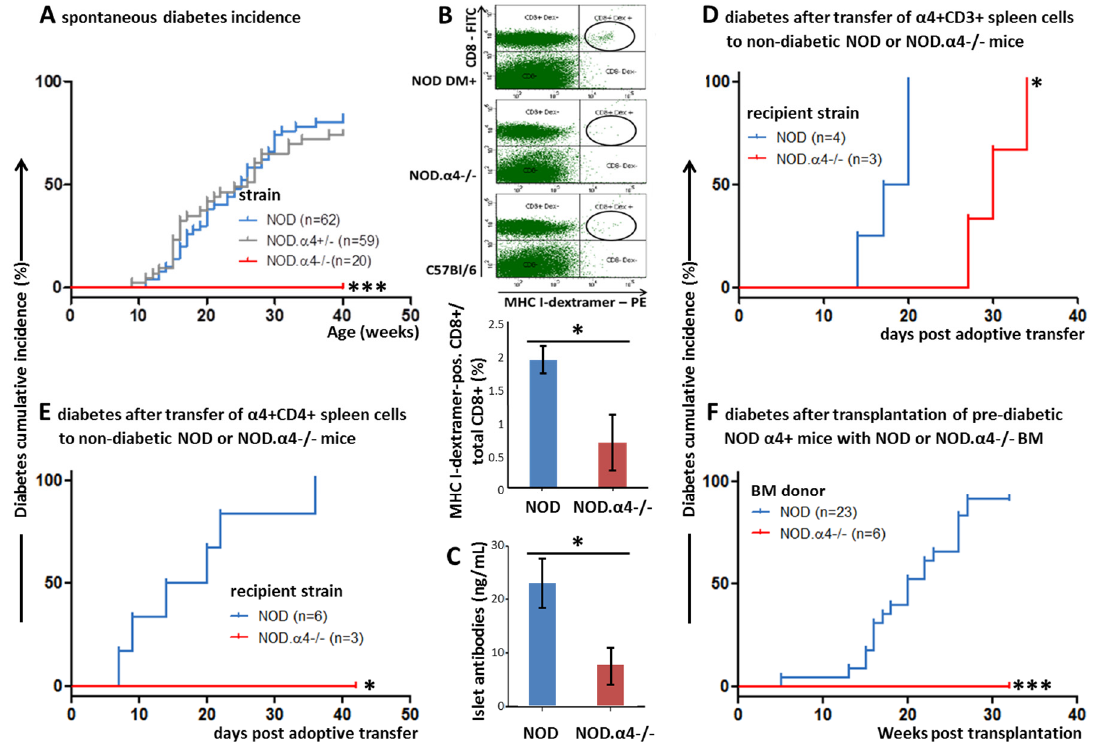
Figure 1. Diabetes and adaptive immune responses against islet antigens. Diabetes was diagnosed on the basis of recurrent hyperglycemia. Spontaneous diabetes development was tracked in α 4-WT (NOD, blue), α 4-haploinsufficient NOD (NOD. α 4+/-, grey) and α 4-deficient NOD (NOD. α 4-/-, red) mice. The cumulative diabetes incidence after 40 weeks in the two α 4-competent strains was 82% (NOD) and 75% (NOD. α 4+/-), respectively ( p = n.s.), while none of the NOD. α 4-/- mice developed diabetes ( p < 0.001 vs. both α 4-competent strains) ( A ). MHC-I dextramer H-2Kd/VYLKTNVFL binding to CD8+ T-cells was assessed by flow cytometry. Shown are representative dot plots for NOD, NOD. α 4-/- and MHC-disparate C57Bl/6 (negative control) mouse blood (upper panel) as well as quantitative analysis (lower panel) where dextramer-positive events in negative control blood were subtracted as background ( n = 9 per group; p < 0.05) ( B ). Anti-insulin autoantibodies were quantified by ELISA ( n = 7 per group; p < 0.05) ( C ). 5 × 10 6 CD3+ splenocytes from diabetic donors were transferred into young adult non-diabetic NOD or NOD. α 4-/- hosts. All recipients became diabetic, but onset of diabetes was significantly delayed in NOD. α 4-/- hosts ( p < 0.05) ( D ). 2.5 × 10 6 CD4+ splenocytes from diabetic donors were transferred into young adult non-diabetic NOD or NOD. α 4-/- hosts. NOD rapidly became diabetic, while NOD. α 4-/- were immune ( p < 0.05) ( E ). Lethally irradiated pre-diabetic young female NOD mice received bone marrow transplants from NOD or NOD. α 4-/- donors. Recipients of NOD bone marrow became diabetic with typical kinetics, while recipients of